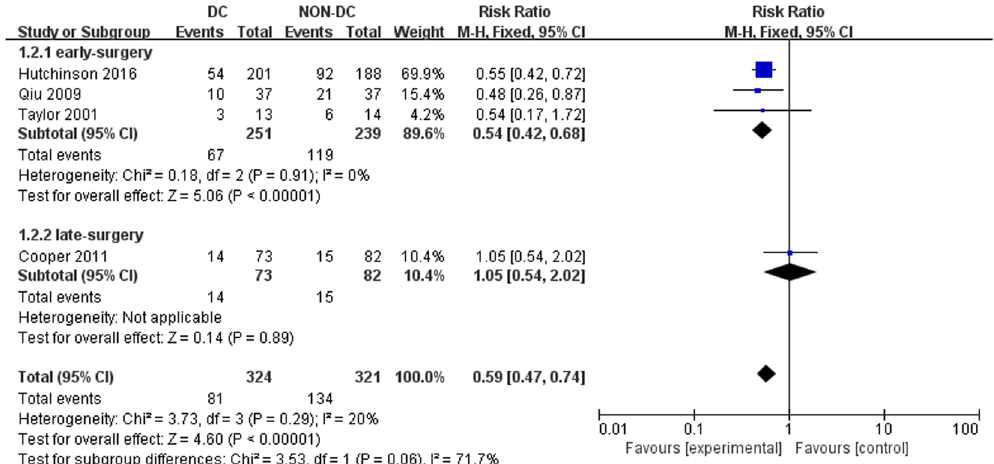
Figure 2. Forest plots for the effect of DC versus NON-DC on overall mortality. DC, Decompressive Craniectomy.